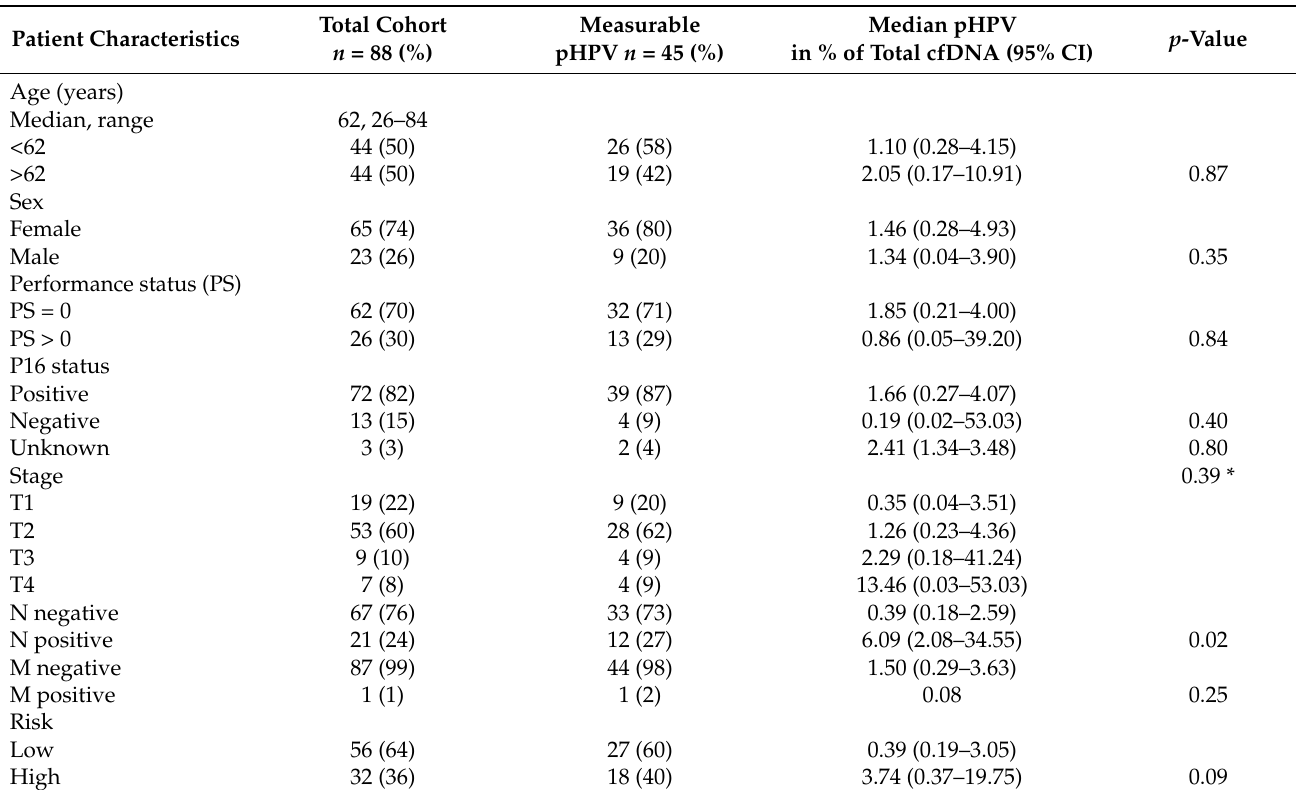
Table 1. Pre-treatment characteristics.